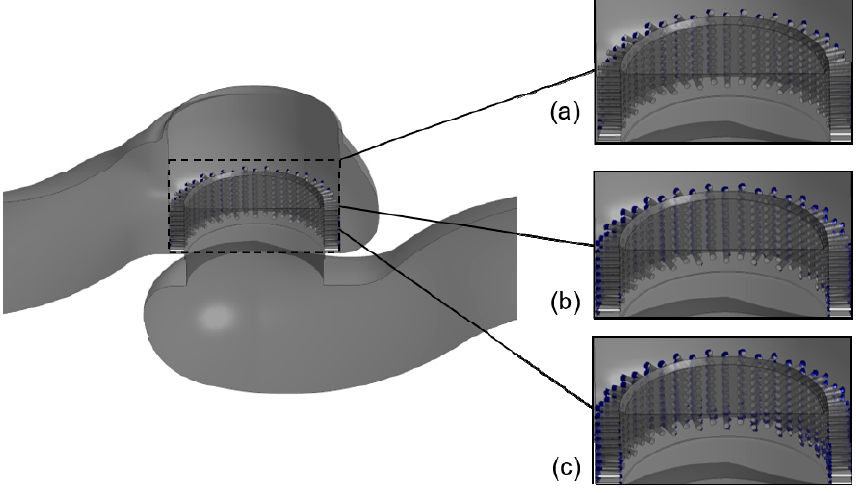
Figure 11. Vapor distributions inside the sleeve regulating valve for different pressure difference with the valve core displacement of 60 mm ( a ) 2 MPa; ( b ) 5 MPa; ( c ) 8 MPa. the valve core displacement of 60 mm ( a ) 2 MPa; ( b ) 5 MPa; ( c ) 8